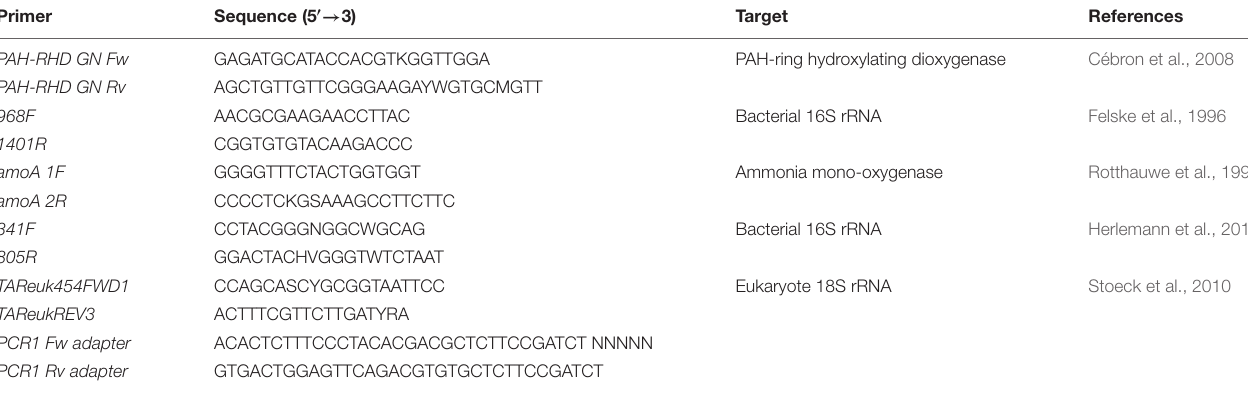
TABLE 2 | List of primers used in the study. Primer Sequence (5 (cid:48) → 3)